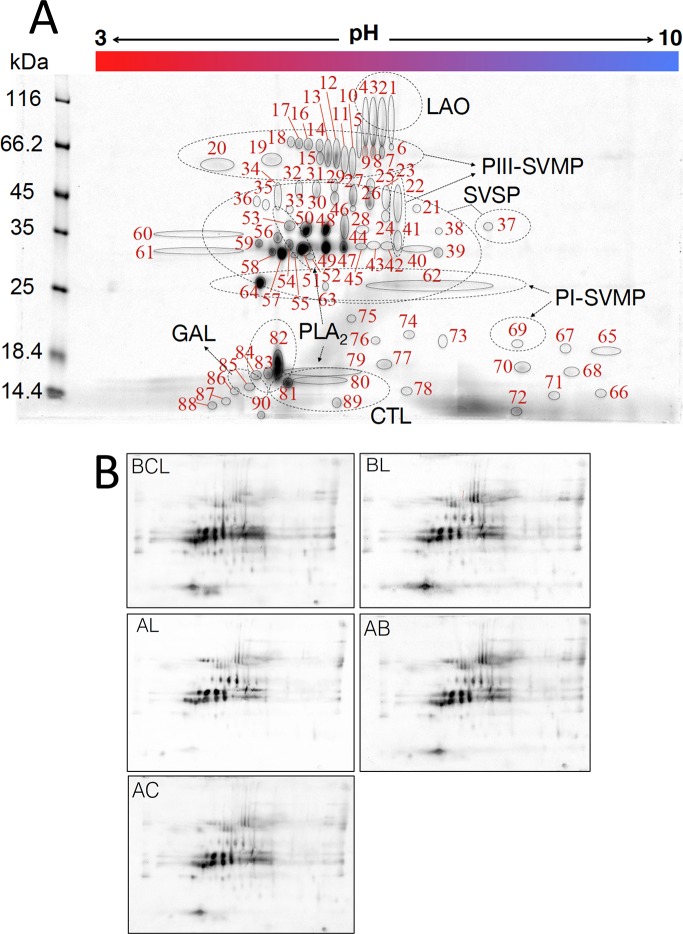
Panel A. 2DE protein map of adult L. stenophrys venom. 350 μg of venom was separated on an 11 cm IPG strip with a pH gradient from 3 to 10 (first dimension) and on a 4–15% SDS-polyacrylamide Criterion TGX gel as second dimension. Proteins were stained with Coomassie Blue. Isoelectric point (IP), apparent Mw, and relative spot intensity were computed using software ImageJ. Protein identification was accomplished by MALDI-TOF-TOF MS. Protein spot features are listed in S1 Table. Panel B. Electroblotted 2DE separated venom proteins from adult L. stenophrys probed against commercial polyspecific BCL antivenom; BL antivenom; and monoespecific AL, AB, and AC antivenoms. Protein identifications by MALDI-TOF/TOF MS are listed in S1 Table (Supplementary Materials).